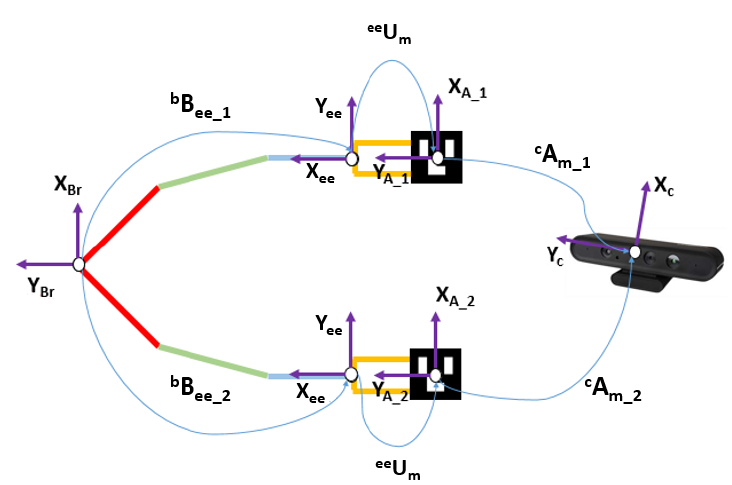
Figure 2. Schematic of the robot—camera problem.